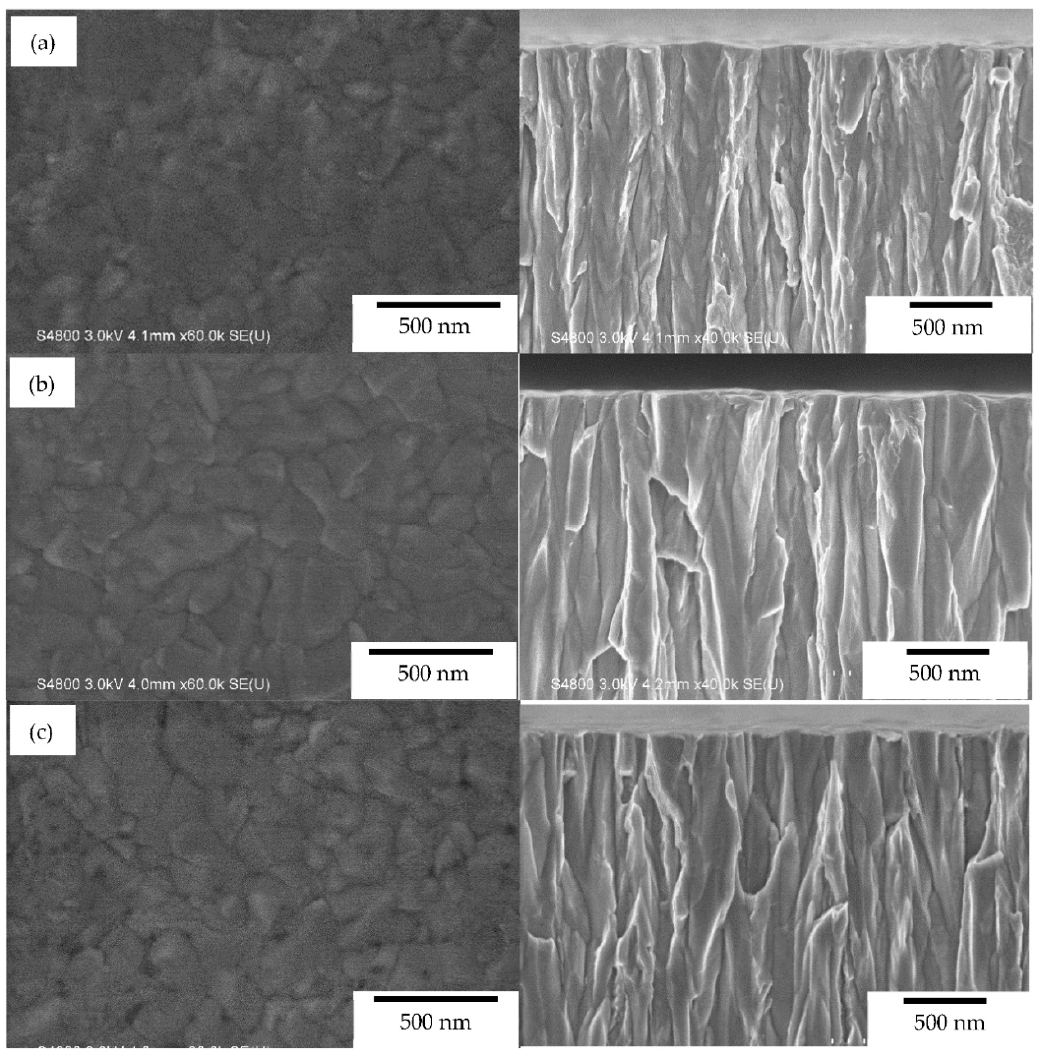
Figure 8. Top (left side) and cross-sectional (right side) SEM SE micrographs of Zr films deposited with the target pulse width of ( a ) 60 μ s, ( b ) 200 μ s, and ( c ) 400 μ s, at the argon pressure of 0.8 Pa on the silicon wafer chips with applying synchronized substrate pulse bias − 200 V.